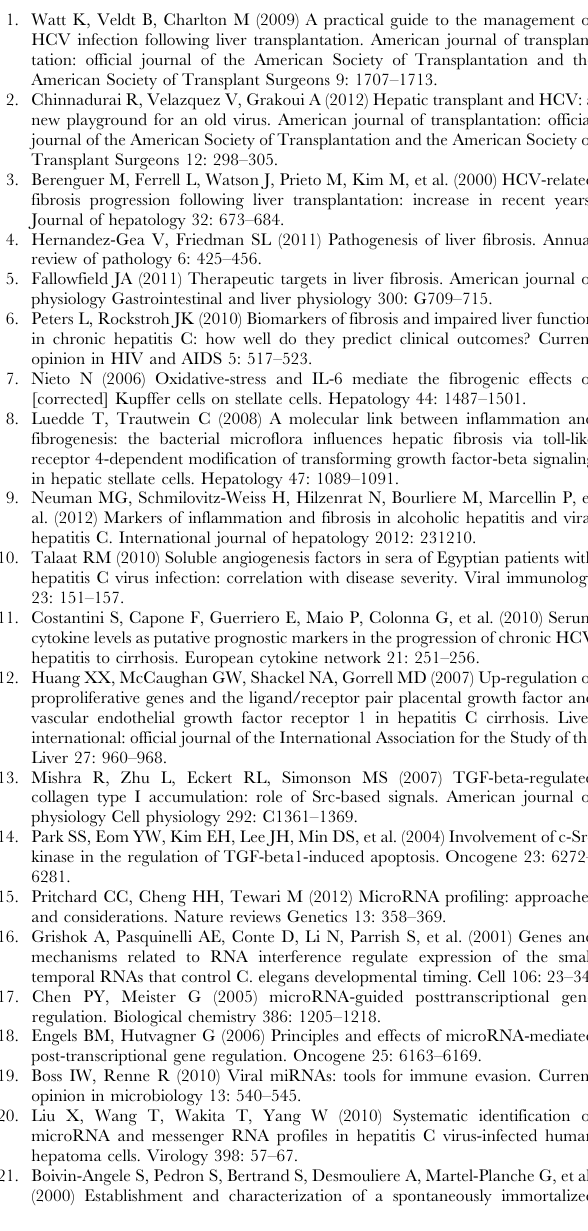
considered to be significant. Chronic HCV patients had greater than two fold increases in the expression of 785 genes and greater than 2 fold reduction in the expression of 533